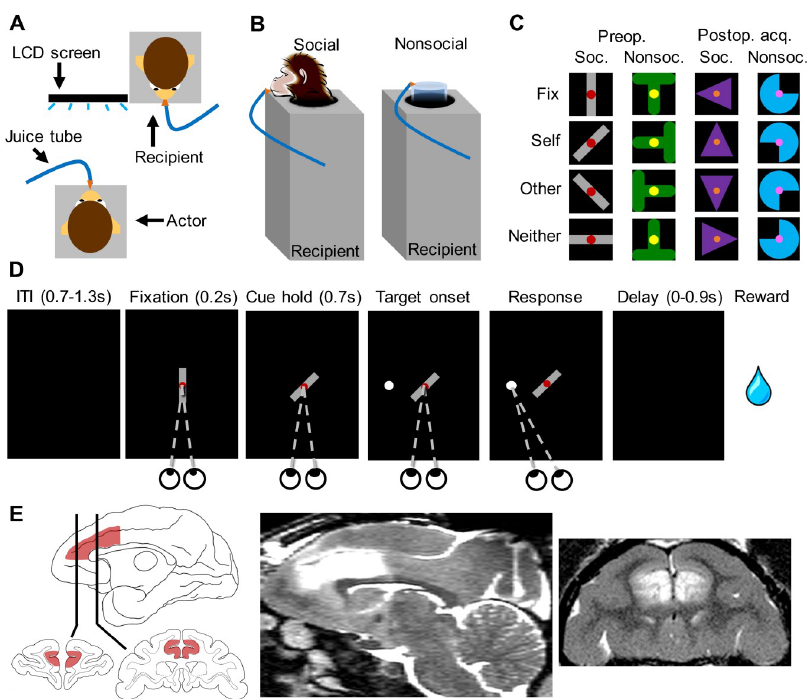
Fig 1. Monkeys completed a social vicarious reinforcement test before and after selective ACC damage. (A) Top- down schematic of the test arrangement with the actor monkey facing an LCD screen next to a recipient. (B) Schematic side view of juice delivery to recipient or juice collection cylinder in Social and Nonsocial sessions. (C) Stimuli used in the Social and Nonsocial sessions in the preoperative test, postoperative retention test, and postoperative acquisition test. The cues used for fixation were rotated to create the 3 reward conditions. (D) Schematic of the trial progression in a Social session in which the stimulus signals that “reward to self” is on offer. If the monkey completed the saccade to the peripheral target, the reward condition on offer for that trial was implemented. Note that the white peripheral saccade target appeared equally often in one of 8 locations equidistant from the center. (E) Diagram of the intended lesion in sagittal and coronal views (left) and postoperative edema (white hypersignal) observed in a T2-weighted MR scan in one monkey in the ACC lesion group. MR images from all monkeys with